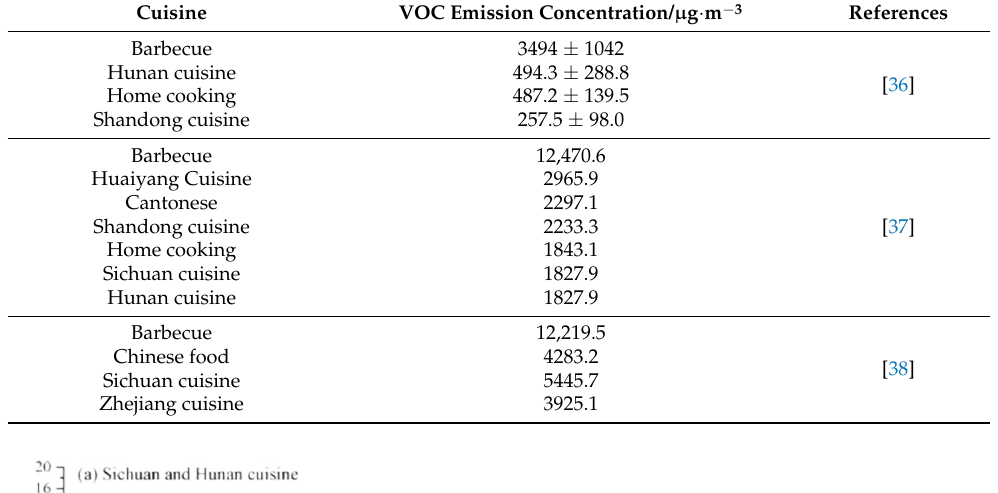
Table 1. VOC emission concentrations in different types of cuisine. Cuisine